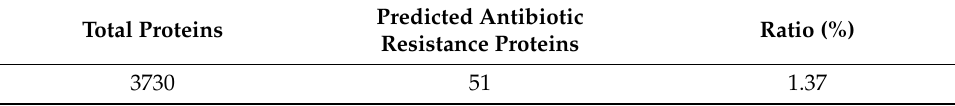
Table 2. Functional annotation of the comprehensive antibiotic resistance database (CARD).